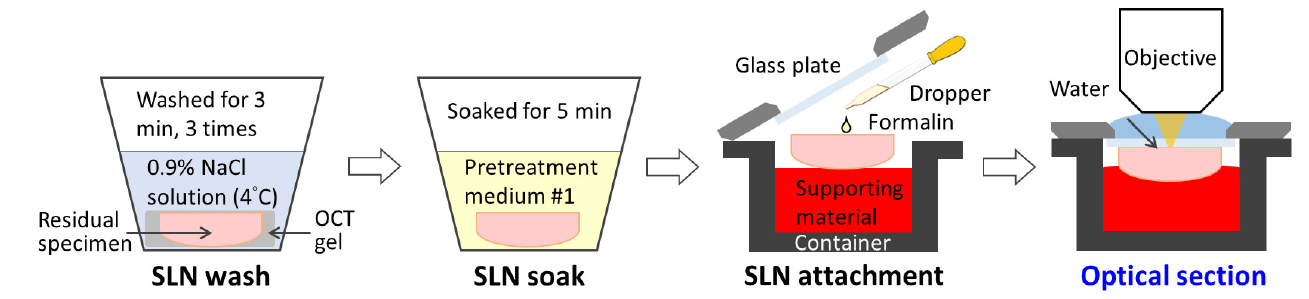
Figure 2. Ex vivo SLN processed from the end of FS to the OCMIS.